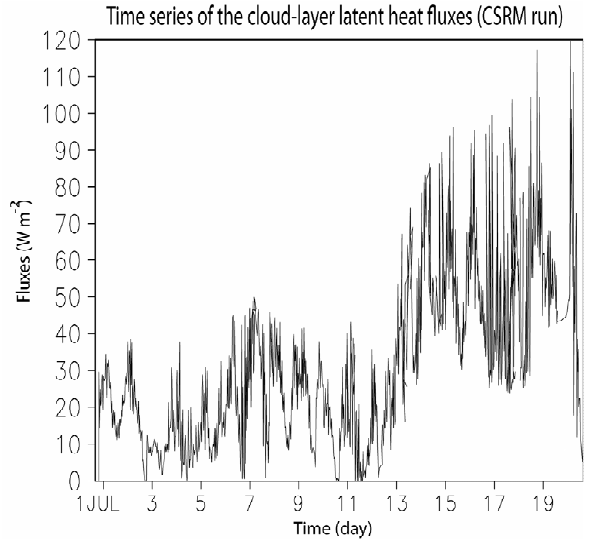
Fig. 16. Time series of the cloud-layer averaged LH fluxes for the CSRM run. When clouds are not present, the cloud layer is defined as a layer between the LCL and the MBL